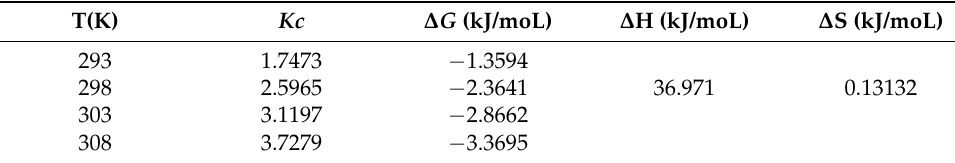
Figure 10. ( a ) Effect of temperature; ( b ) plot of ln Kc versus 1/T. Table 3. The thermodynamic parameters at different temperatures.